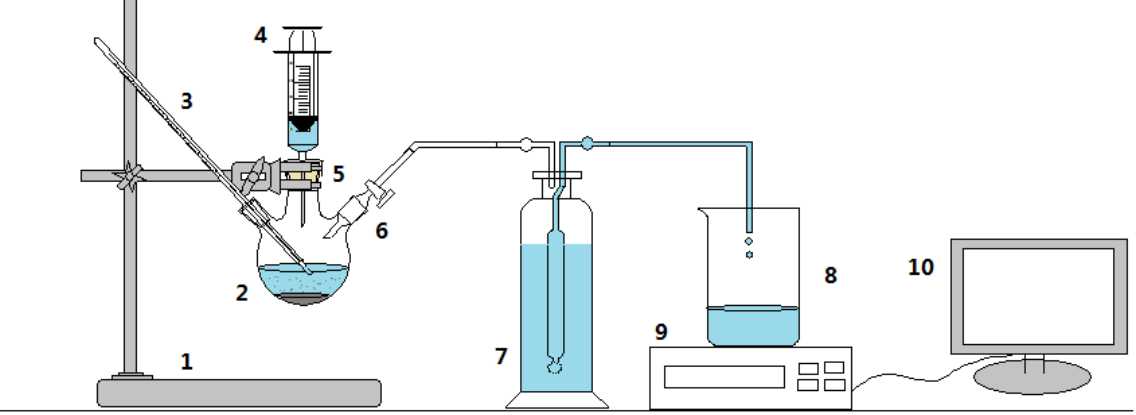
Figure 1. The schematic of equipment used to quantify hydrogen production rates and yields: (1) iron support; (2) Pyrex glass reactor; (3) thermometer; (4) injector; (5) double gum plug; (6) piston joint; (7) Monteggia washing bottle filled with water at room temperature; (8) beaker to collect the extracted water; (9) electronic scales; (10)